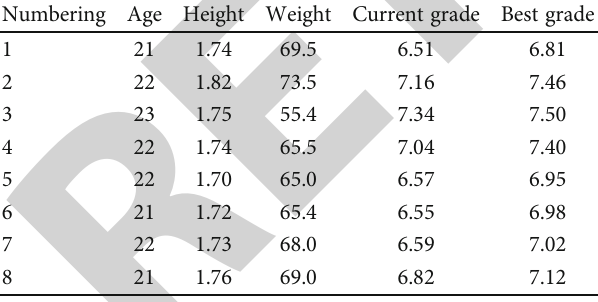
Figure 5: Schematic diagram of human skeletal muscle hierarchy model. Table 1: Basic situation of experimental